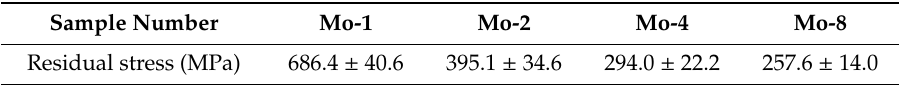
Figure 8. (Color online) ( a ) XRD patterns of the Mo-1 sample showing the peak shift of Ti (112) as a function of ψ angle. ( b ) In-plane residual stress derived from the XRD patterns in (a) using the sin 2 ψ method for the Mo-1, Mo-2, Mo-4, and Mo-8 samples. Table 3. The residual stresses of the Si / Mo / Ti multilayer films determined by XRD using the sin 2 ψ method. The standard deviation was obtained by fitting the data points of △ d / d verse sin 2 ψ using the linear least square method.